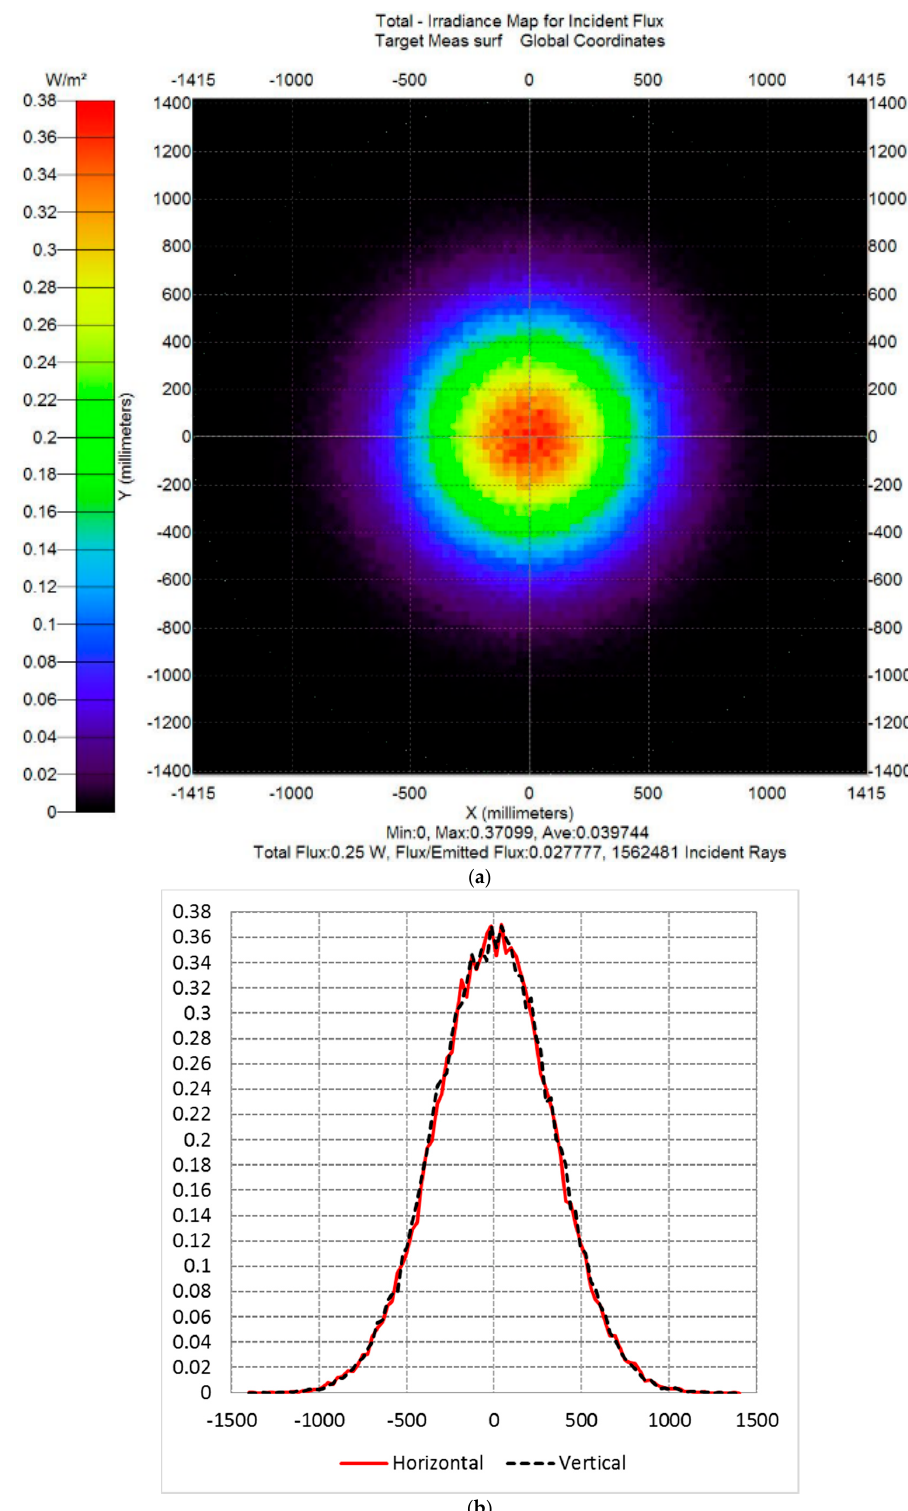
Figure 3. Target irradiance map ( a ) and corresponding central profiles ( b ) with mirror side L F = 0.5 m.